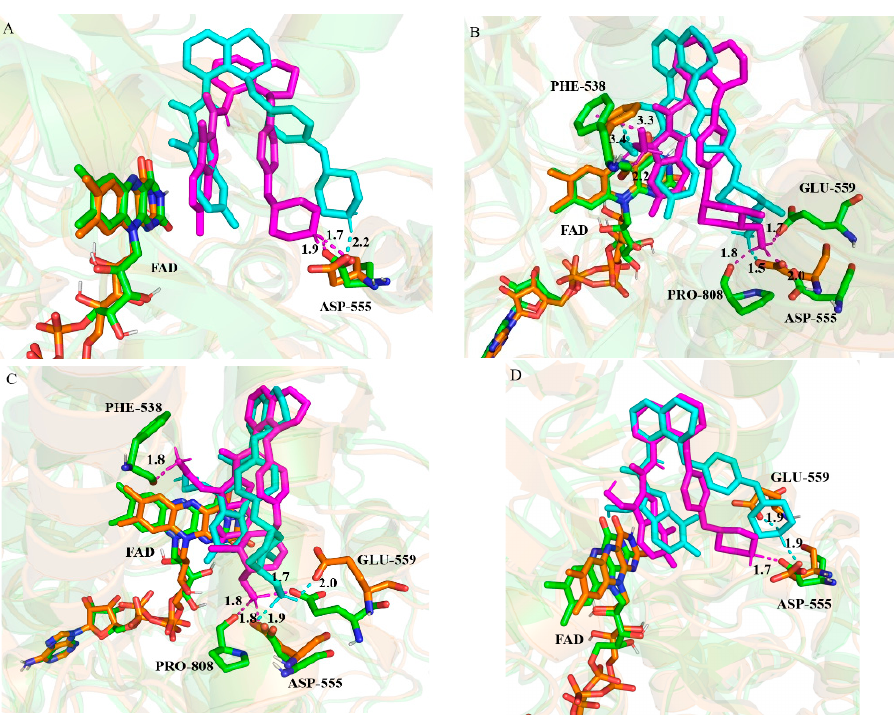
Figure 7. The superposition of the docking structures and MD average structures of complexes LSD1–18x ( A ), LSD1–D1 ( B ), LSD1–D4 ( C ), and LSD1–Z17 ( D ). The key residues and compounds of molecular docking structure are in orange and cyan, respectively. The key residues and compounds of the average structures are shown in green and